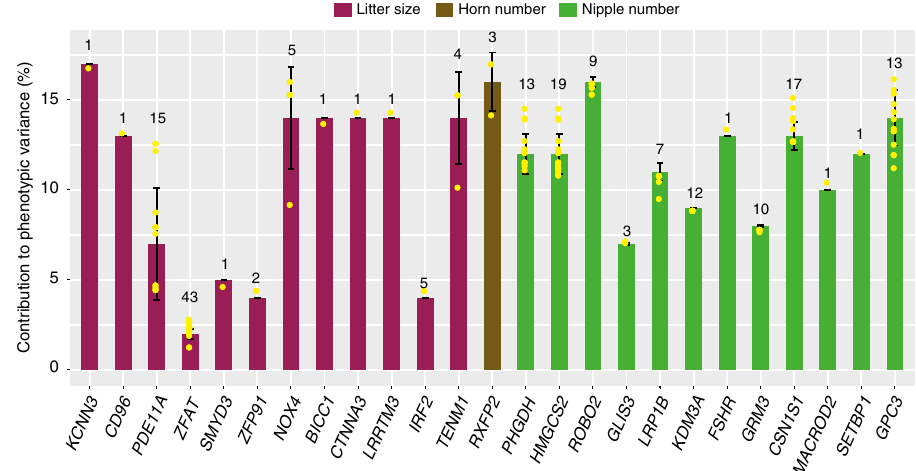
Fig. 6 Average contributions of loci to phenotypic variances of three traits. The identi fi ed genetic loci are located within ±20 kb of 25 candidate selected genes of the traits of litter size and numbers of horns and nipples. The number of signi fi cant loci within each gene is indicated at the top of each bar and the data are presented as the mean ± SD. The proportion of the phenotypic variation explained for each signi fi cant locus is listed in Supplementary Data